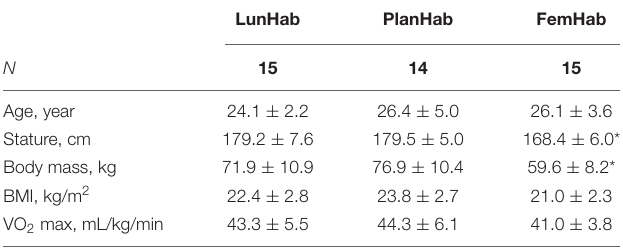
TABLE 1 | Baseline characteristics of the